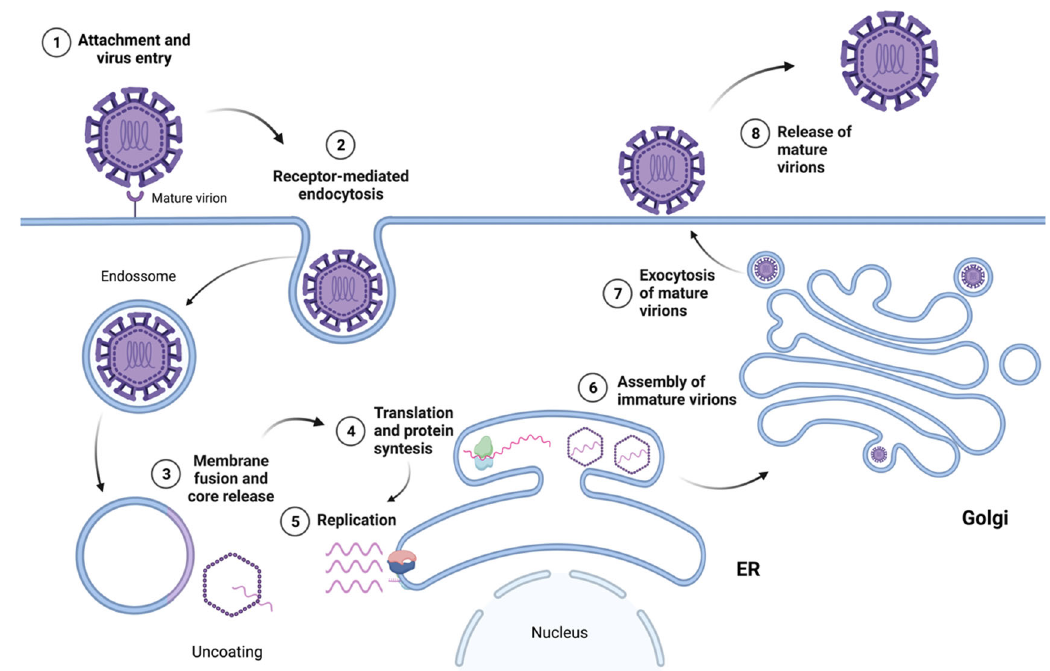
Figure 3. Overview of the flavivirus life cycle.